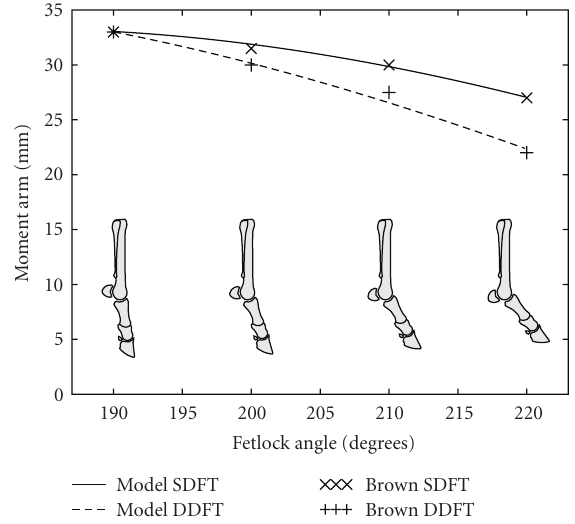
Figure 2: Moment arms from the forelimb model compared with those published by Brown et al. [16]. Moment arms for the forelimb model were calculated using a simulated tendon excursion